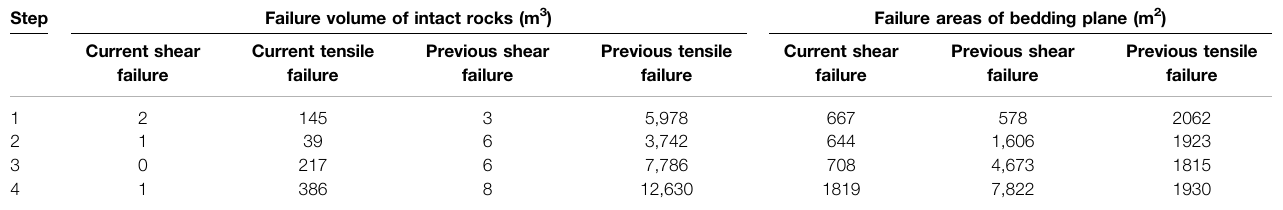
TABLE 7 | Summary of the rock mass failure indices under supported